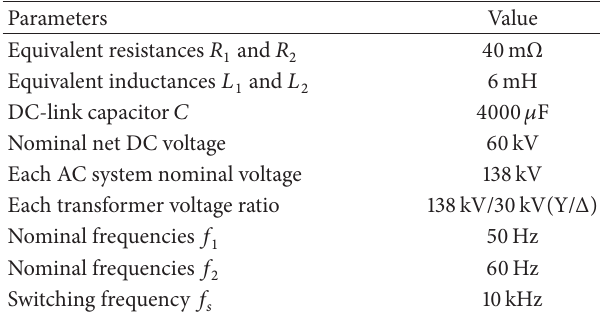
Table 1: The main parameters of BTB